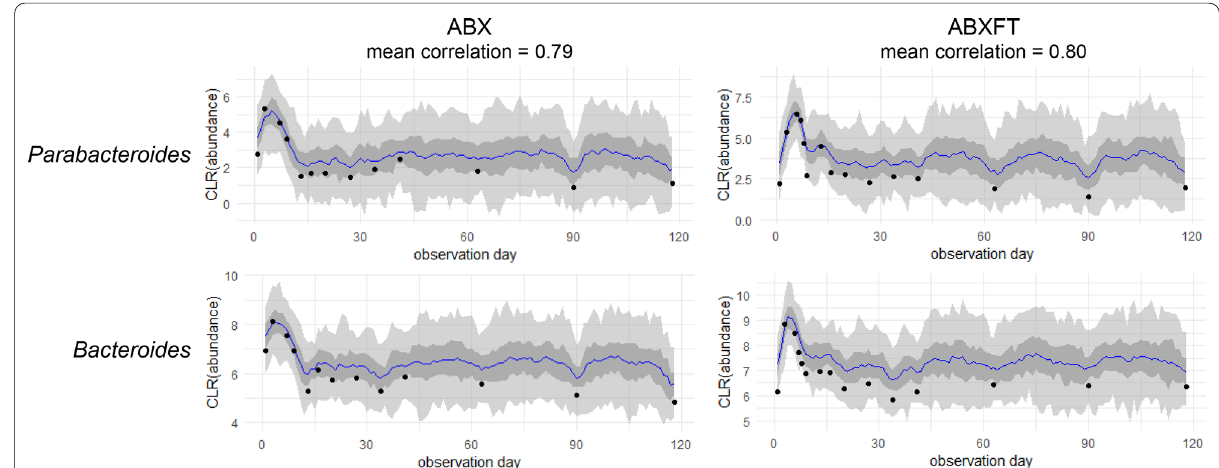
Fig. 5 Representative correlation plots for the association between the Centered Log Ratios (CLR; black dots) of Bacteroides and Parabacteroides abundances in healthy, male ring‑tailed lemurs ( Lemur catta ) either treated with antibiotics only (ABX) or with antibiotics plus fecal transfaunation (ABXFT). The blue line is the model‑predicted trajectory with the dark and light gray bands representing 50% and 95% posterior predictive intervals, respectively. The antibiotic treatment period spans days 0–6, fecal transfaunation was administered on day 7, and all days thereafter constitute the period of